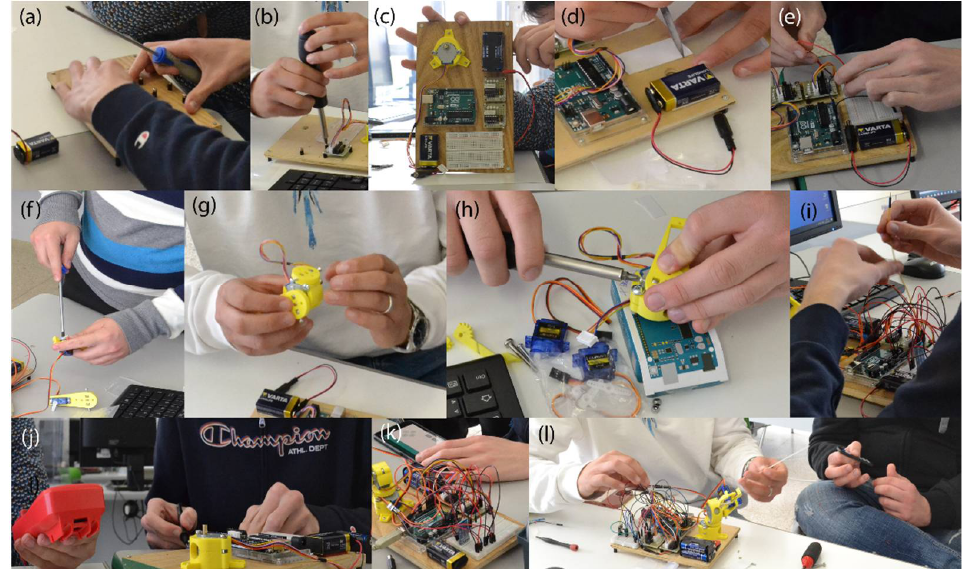
Figure 5. The final phase of the project: ( a – e ) fixing of the hardware pieces; ( f – h ) assembly of the mechanical part of the robotic arm; ( i ) cabling; ( j ) power supply testing; ( k,l ) Bluetooth and IR control testing.